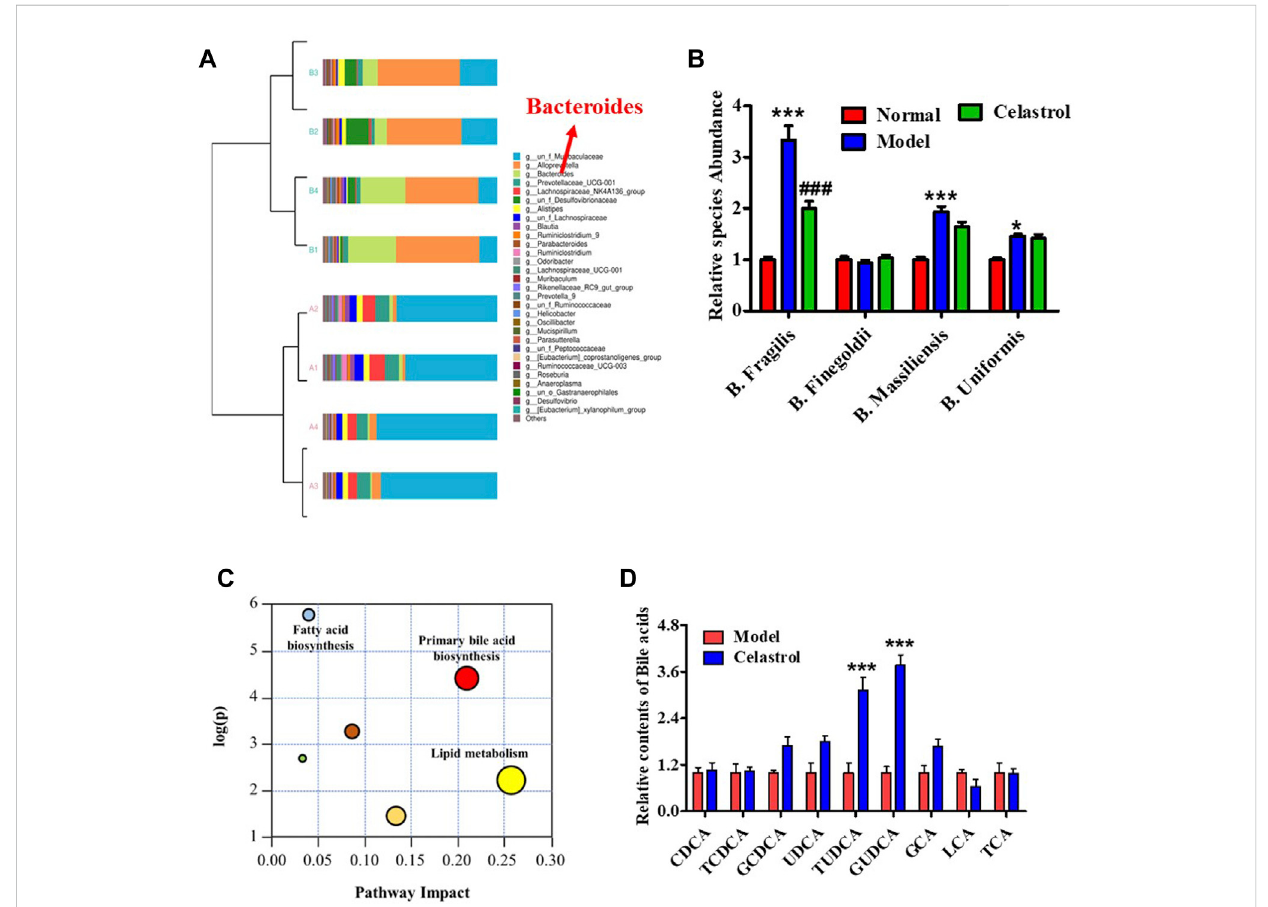
FIGURE 2 Celastrol regulates gut microbiota and bile acid metabolism in rats with HCC. (A) Cluster diagram of bacterial structure. (B) Different species abundanceof Bacteroides ,* p < 0.05,*** p < 0.001vs.normalgroup; ### p < 0.001vs.modelgroup. (C) Metabolism pathwayanalysis. (D) Bileacidslevelin liver, *** p < 0.001 vs. model